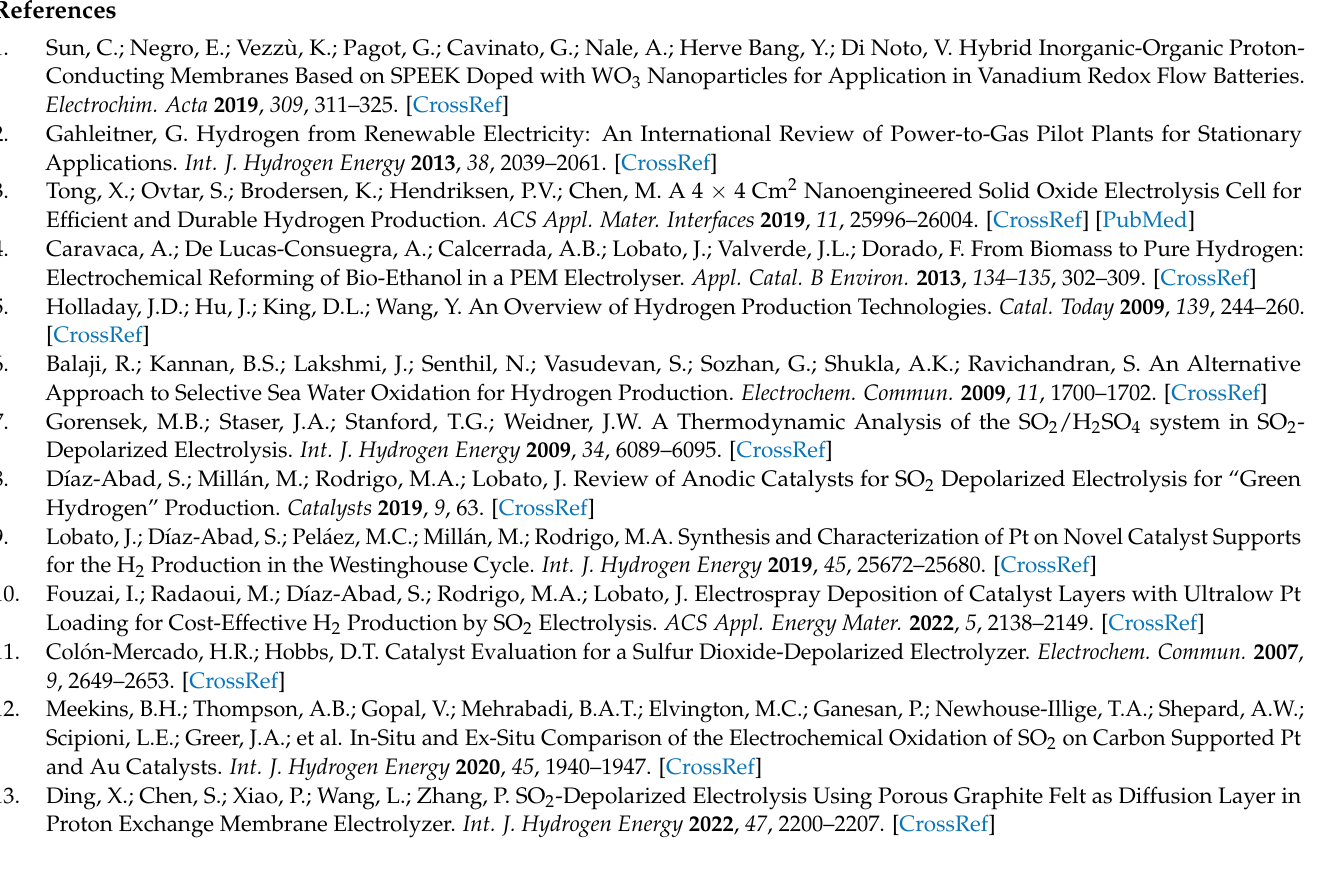
Figure S4: Chemical stability test. Time at which each membrane failed; Figure S5: Nyquist plots at 0.7 V for the studied membranes. Green dots: 110 ◦ C; Blue dots: 120 ◦ C; Orange dots: 130 ◦ C; Red dots: 140 ◦ C; Figure S6: H 2 S contents in the cathode outlet measured at 0.6 V; Figure S7: H 2 SO 4 production efficiency in the anode measured at 0.6 V. Black column: Std-PBI; Red column: 0.5 wt% TiO 2 -PBI; Yellow column: 1.0 wt% TiO 2 -PBI; Green column: 2.0 wt% TiO 2 -PBI; Blue column: 3.0 wt% TiO 2 -PBI, Table S1: SO 2 crossover